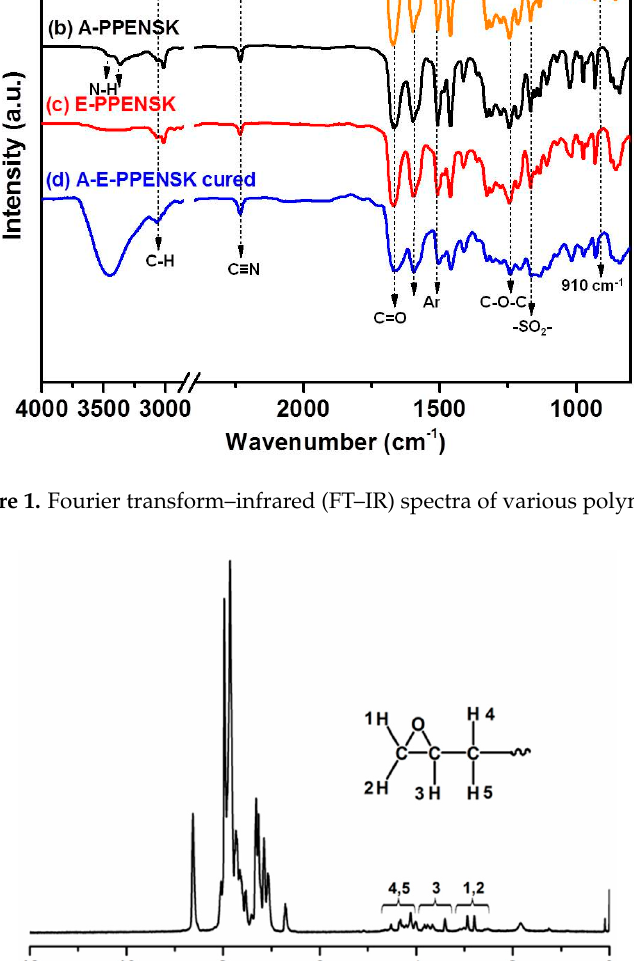
Figure 1. Fourier transform–infrared (FT–IR) spectra of various polymers.